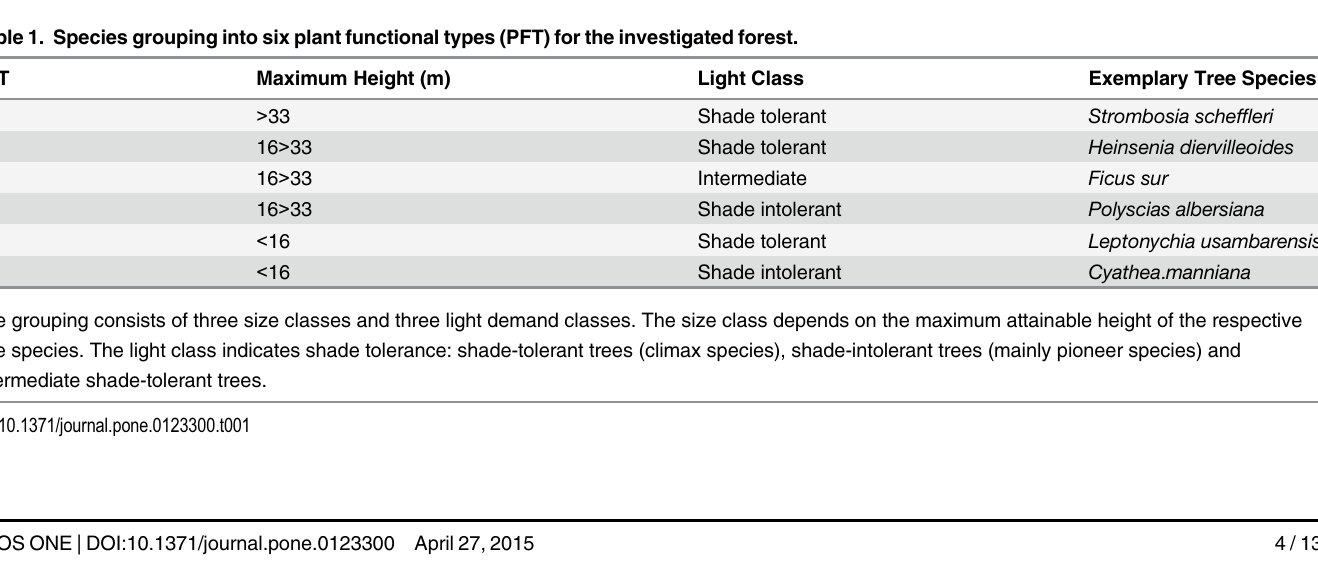
Table 1. Species grouping into six plant functional types (PFT) for the investigated forest. PFT